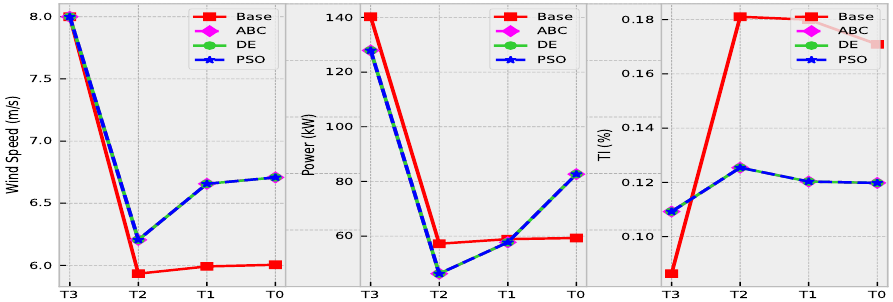
Figure 14. 6 D deployment distance at 8 m/s mean wind speed.